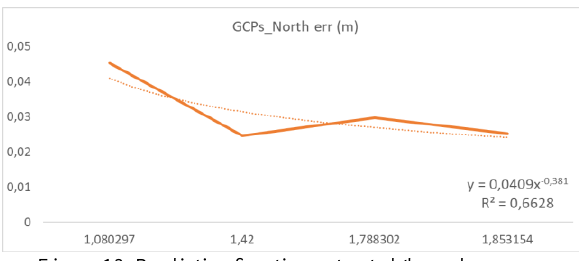
Figure 13. Predictive function extracted through a power interpolation between depend (synthetic index) and independent variables (northern error component). R 2 : coefficient of determination.